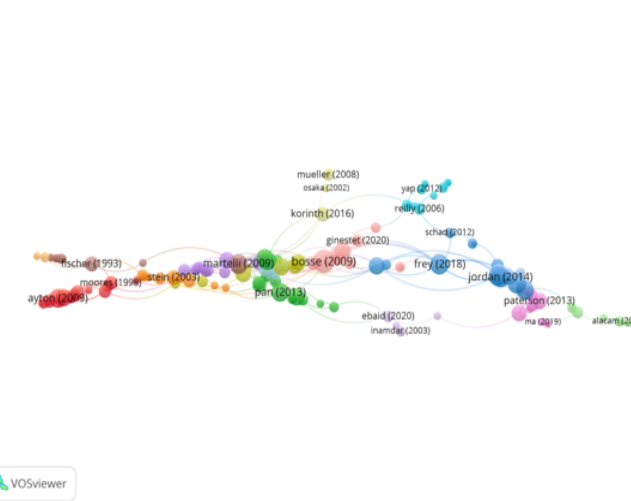
Figure 11. Citation network in Group